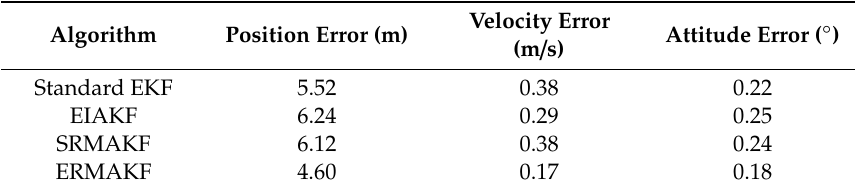
Table 1. 3-Dimensional Navigation Errors for Di ff erent